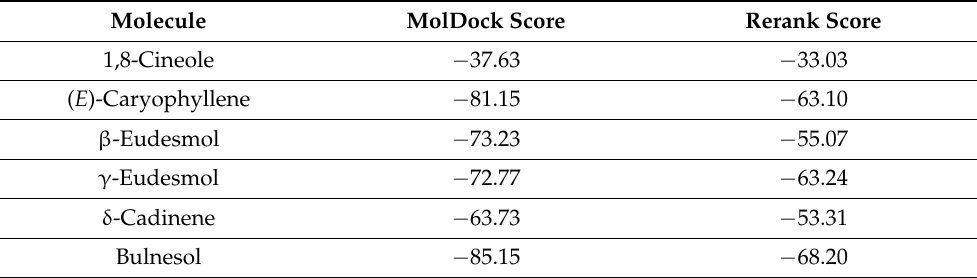
Table 2. Moldock scores obtained from the docking protocol using Molegro Virtual Docker 5.5. Molecule MolDock Score Rerank Score 1,8-Cineole − 37.63 −